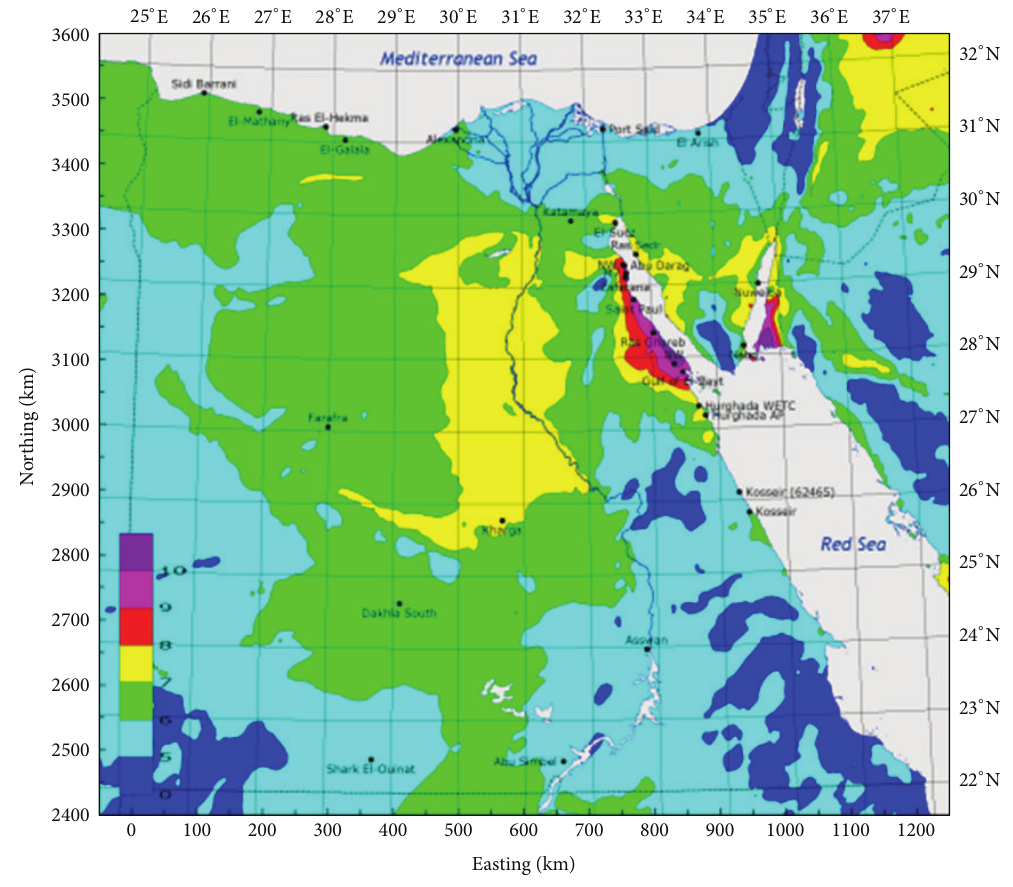
Figure 8: Wind atlas of